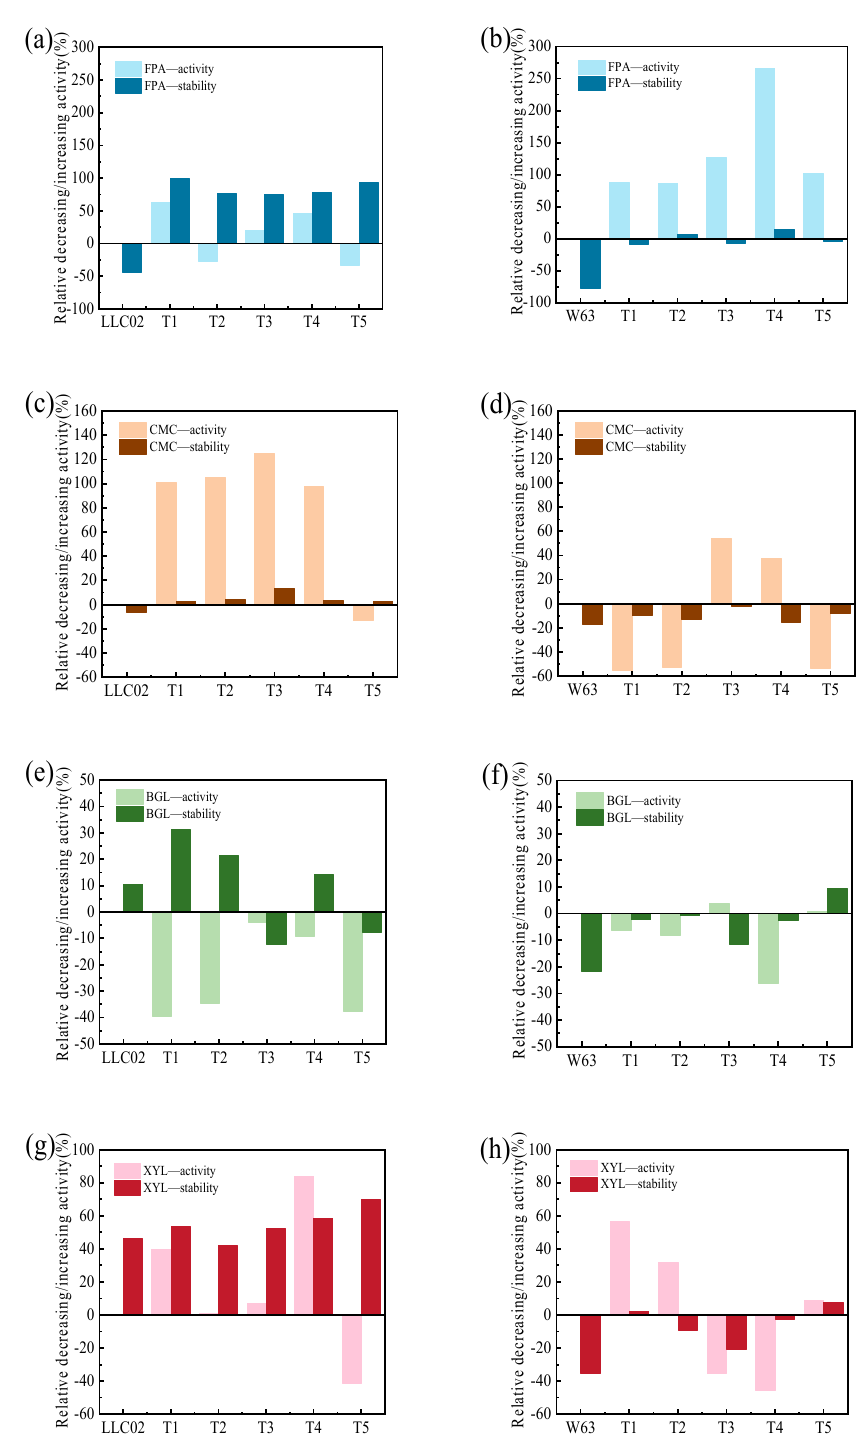
Figure 4. Effects of different compound additives on relative decreasing/increasing enzyme activities and stability of LLC02 and W 63 . T1—methanol + sophorolipid (C1 + SL); T2—n-butanol + sophorolipid (C4 + SL); T3—n-pentanol + sophorolipid (C5 + SL); T4—isoamyl alcohol + sophorolipid (I5 + SL); T5—n-decanol + sophorolipid (C10 + SL). ( a ) Fpase activity and stability of LLC02; ( b ) Fpase activity and stability of W 63 ; ( c ) CMCase activity and stability of LLC02; ( d ) CMCase activity and stability of W 63 ; ( e ) p NPGase activity and stability of LLC02; ( f ) p NPGase activity and stability of W 63 ; ( g ) Xylanase activity and stability of LLC02; ( h ) Xylanase activity and stability of W 63 . Relative decreasing/increasing enzyme activities was standardized by the experiment without